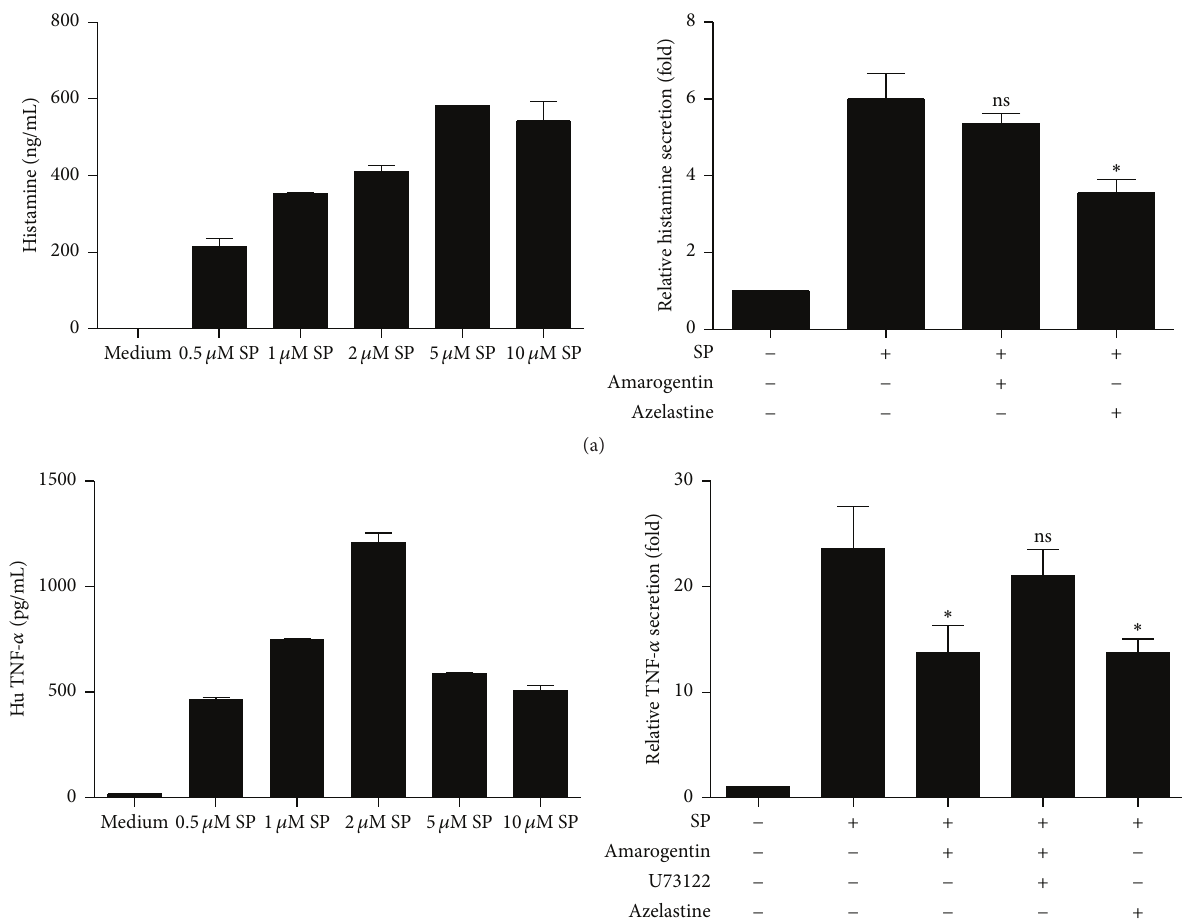
Figure 1: Amarogentin inhibits substance P- (SP-) triggered mediator release from the human mast cell line LAD-2. LAD-2 cells were stimulated with increasing concentrations of SP. LAD-2 cells stimulated with 2 𝜇 M SP were preincubated with amarogentin (100 𝜇 M) or the positive control azelastine (24 𝜇 M). A part of the amarogentin stimulated group was preincubated for 30 min with the PLC inhibitor U73122 (10 𝜇 M). Histamine (a) and TNF- 𝛼 (b) release was measured 20 min after SP stimulation. The data are shown with standard deviation (SEM) and were analyzed with the unpaired, two-tailed 𝑡 -test ( ∗ 𝑝 < 0.05 ; ns: not statistically significant; 𝑛 = 3